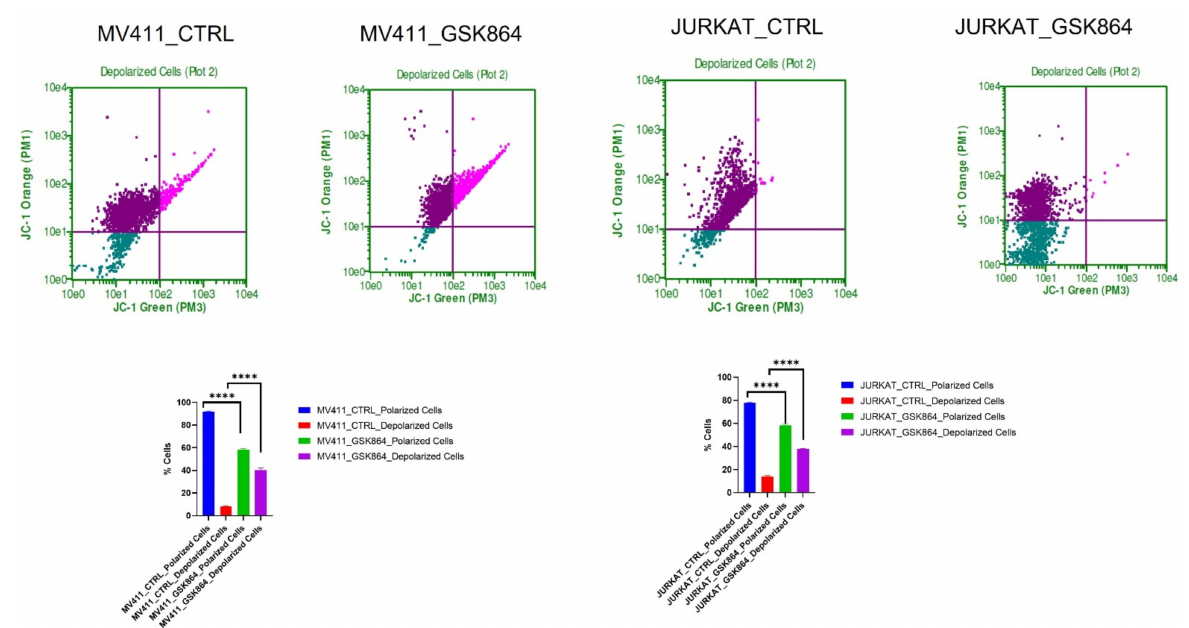
Figure 6. IDHi alters MMP in leukemic cells. Quantitative levels of mitochondrial membrane potential alteration in control-treated leukemic cell; **** p < 0.0000. 2.6. Wild-Type IDH1 Inhibition Promotes the Accumulation of Intracellular ROS and Induces Apoptosis ROS (reactive oxygen species) are involved in the loss of growth control, genomic instability, and invasiveness. References [12,13] showed that disproportionate ROS is harmful to cells, resulting in oxidative damage to RNA, DNA, and proteins. In leukemic cells, IDHi elevated the ROS level in MV4-11 and Jurkat cells. We observed that IDHi induced intracellular ROS levels of 6% in MV4-11 cells, and Jurkat cells showed a 2% induction in intracellular ROS levels (Figure 7).